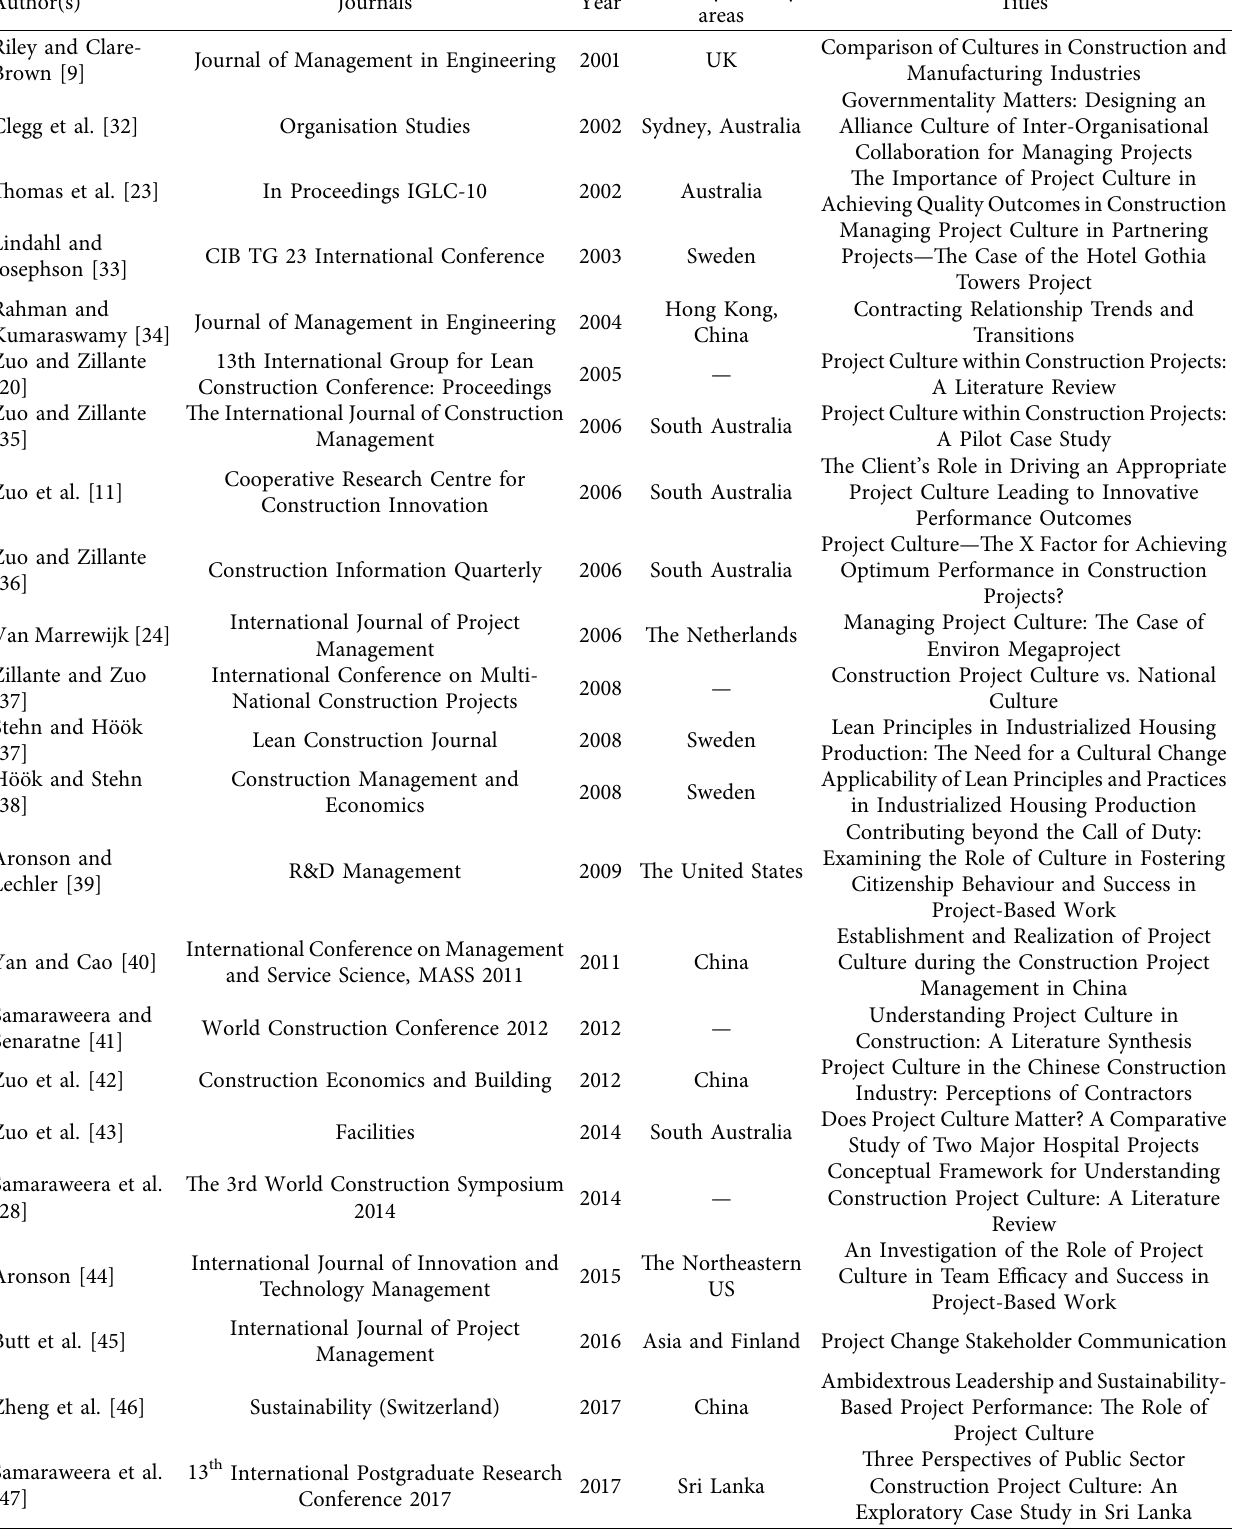
Table 1: Overview of the 31 journal articles in this